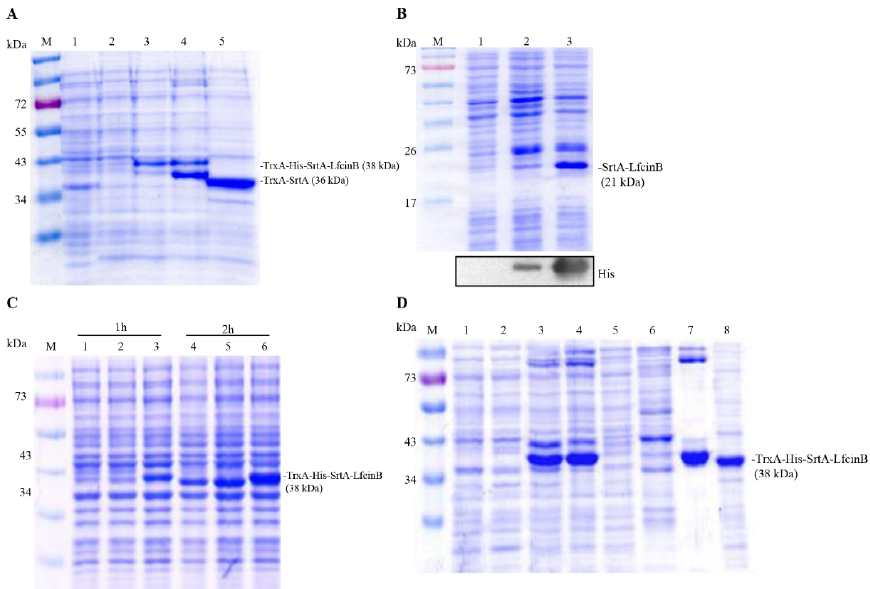
Figure 4. Expression and purification of the SrtA-LfcinB fusion protein. ( A ). The pET32a-SrtA-LfcinB construct was induced in E. coli C43(DE3) followed by induction with IPTG (200 mM) for 3 h at 30 °C. The expressed TrxA ‐ His ‐ SrtA and TrxA ‐ His ‐ SrtA ‐ LfcinB fusion protein (38 kDa) was